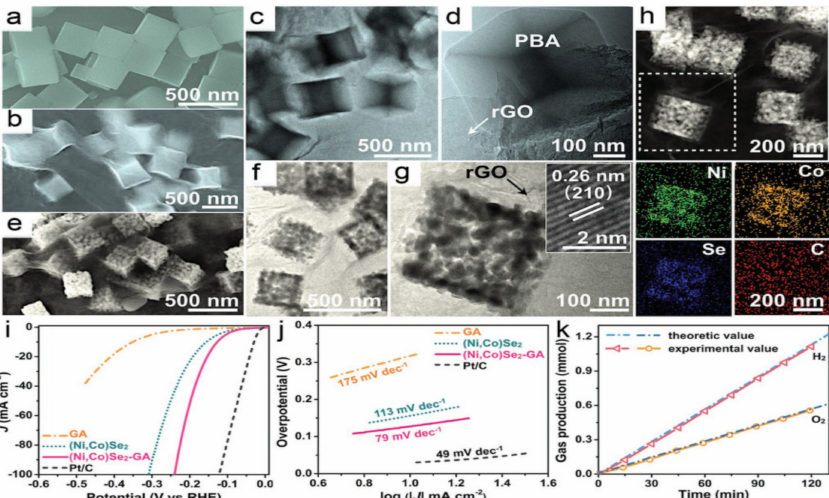
Figure 14. ( a ) SEM image of NiCo PBA nanocubes. ( b ) SEM and ( c , d ) TEM images of NiCo PBA- GA. ( e ) SEM, ( f , g ) TEM images, and ( h ) HADDF image and the corresponding elemental maps of (Ni,Co)Se 2 -GA. The inset of ( g ) shows the HRTEM image of (Ni,Co)Se 2 -GA. ( i ) IR-corrected HER polarization curves of (Ni,Co)Se 2 -GA ( j ) Corresponding Tafel plots. ( k ) H 2 and O 2 production catalyzed by (Ni,Co)Se 2 -GA in 1 m KOH at room temperature. (Reprinted with permission from reference [154]. Copyright 2017, American Chemical